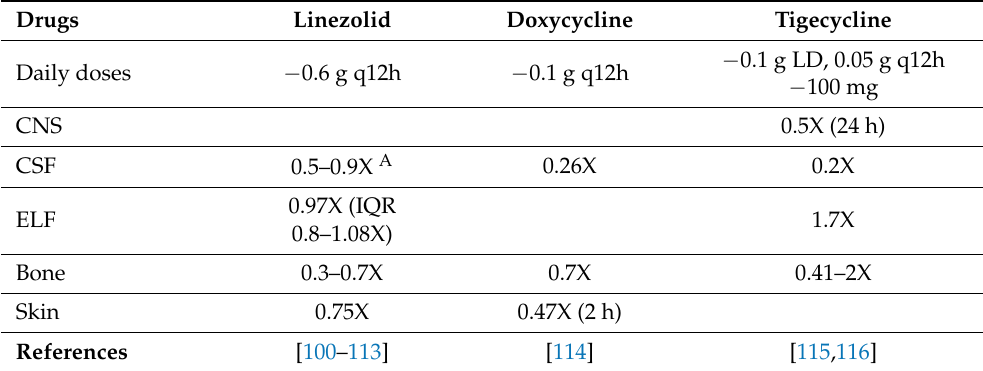
Table 3. The tissue/plasma ratio values of linezolid, doxycycline, and tigecycline. For each drug, the different daily doses that were administered to ICU patients are listed in the